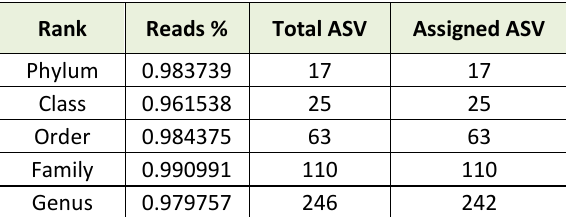
TABLE 2. Taxonomic analysis